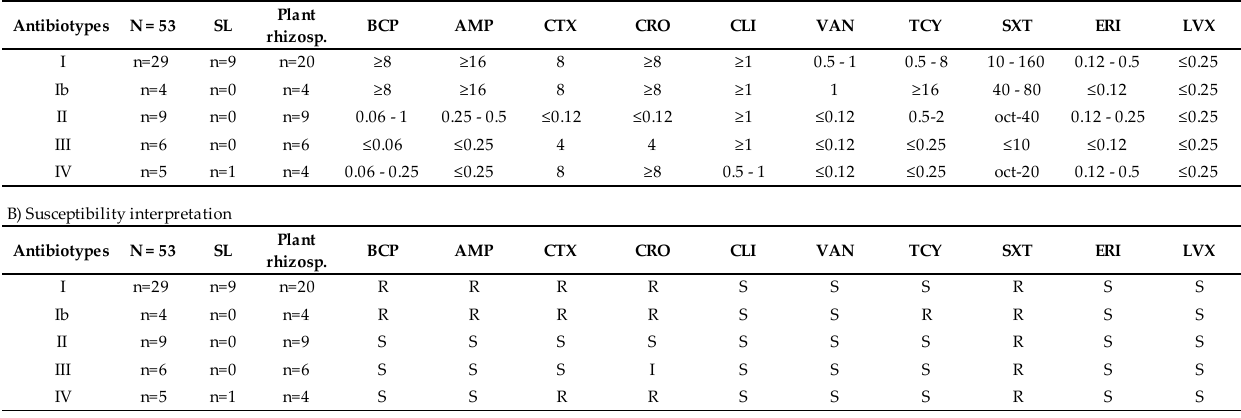
Figure 2. Antibiotic susceptibility of the Bacillus strains. SL: Bacillus spp. strains isolated from bulk soil. Plant rhizosph.: Bacillus spp. strains isolated from assayed plant rhizospheres. Antibiotics included on the Vitek ® 2 AST-ST01 card ( μ g/mL):